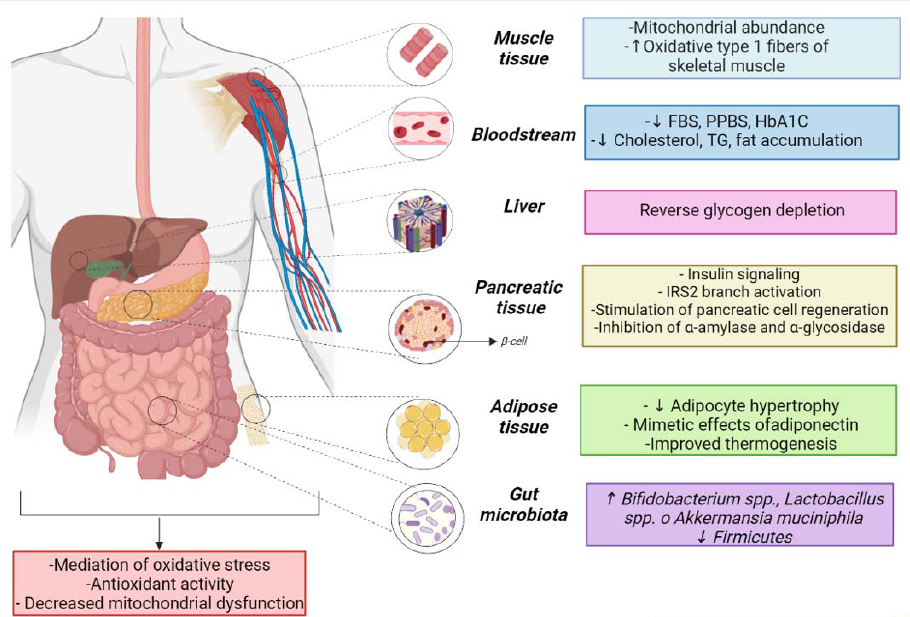
Figure 6. Mechanisms of action in DM related to natural products derived from the patent reviewed. ( ↑increase ↓decrease )